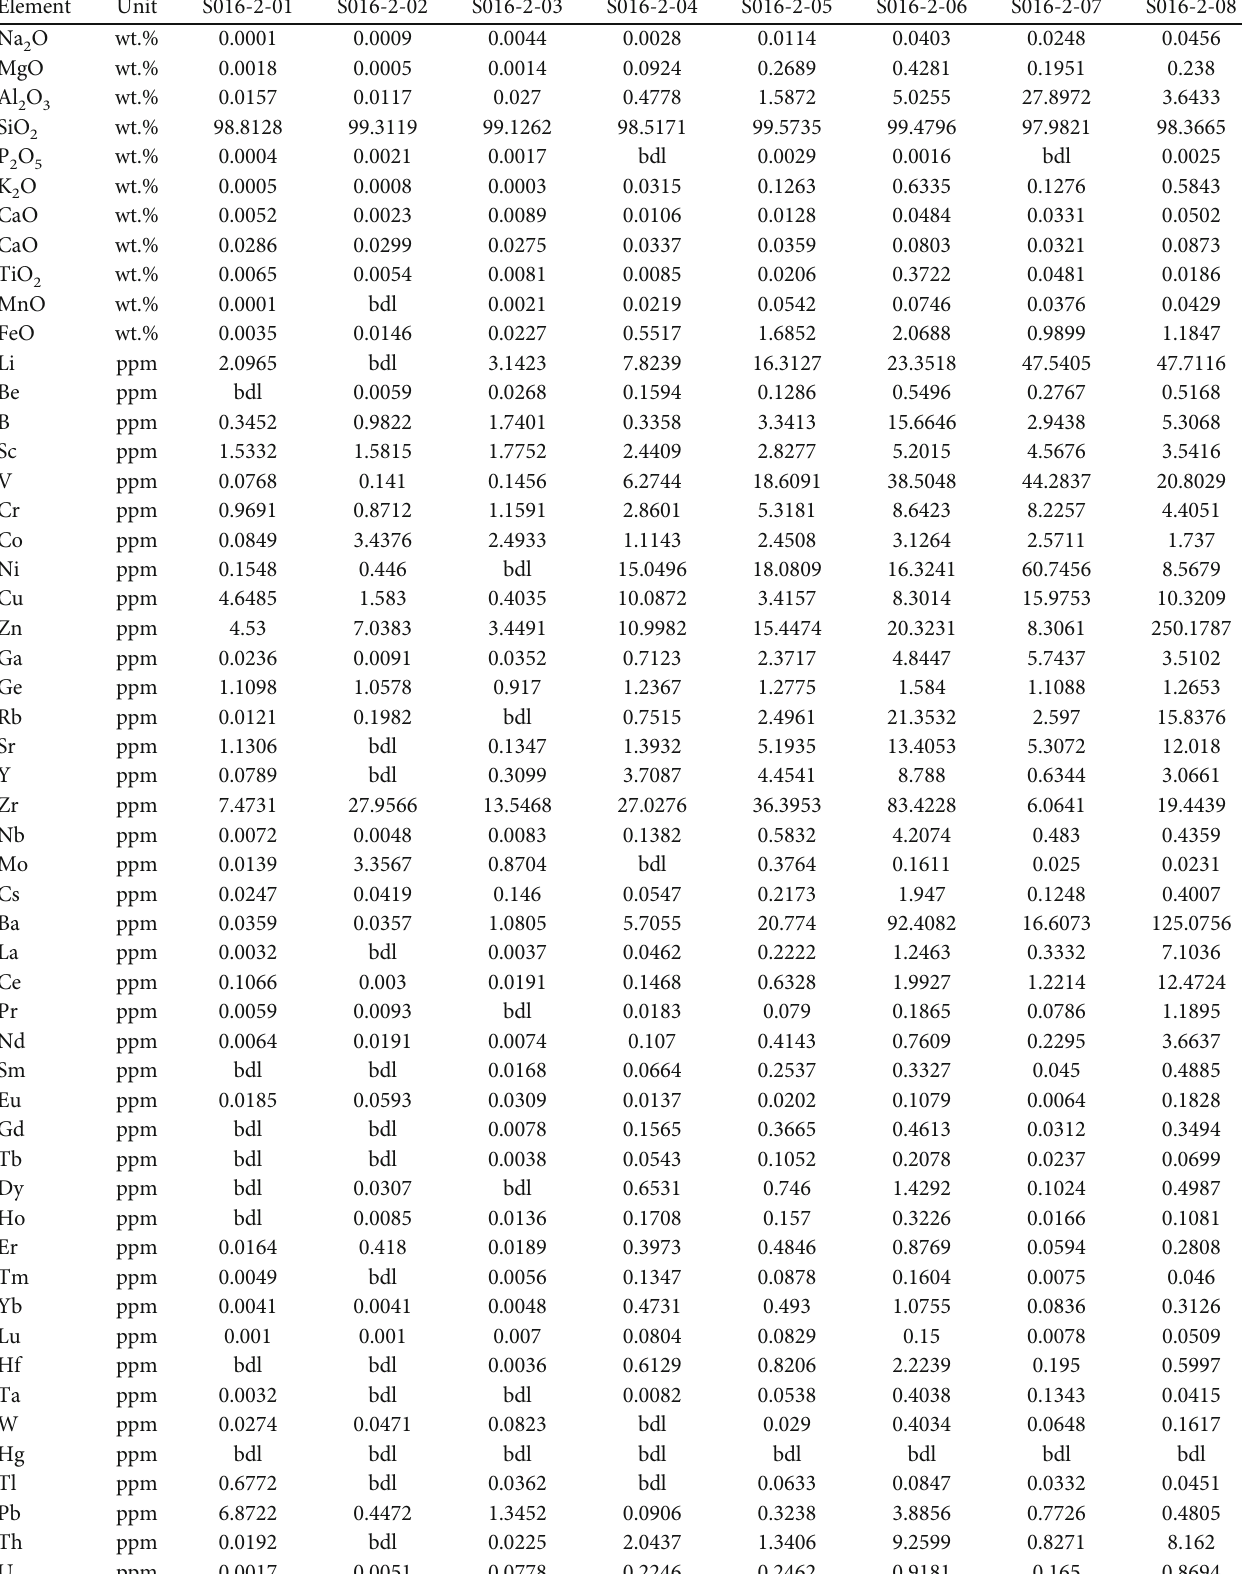
Table 3: In situ major and trace element data for quartz in the D13 well. Sample S016, 4209m